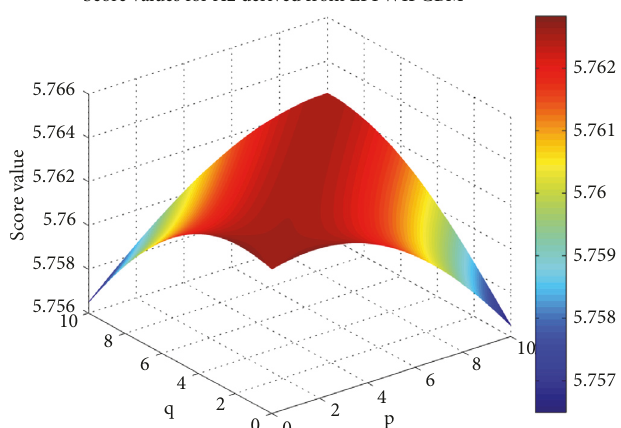
Figure 7: Score values of alternative A2 derived from LPFWIPGBM when 𝑝,𝑞 ∈ (0,10) .